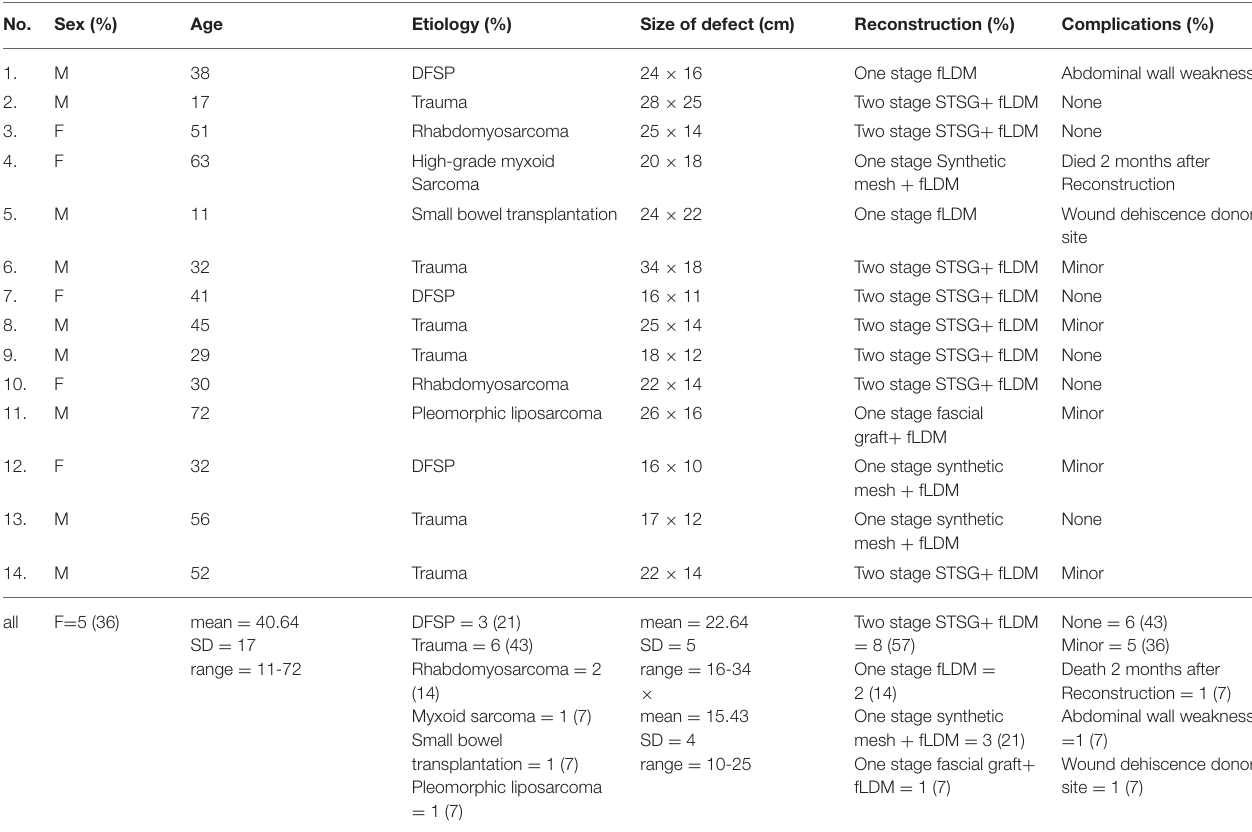
TABLE 1 | Patients’